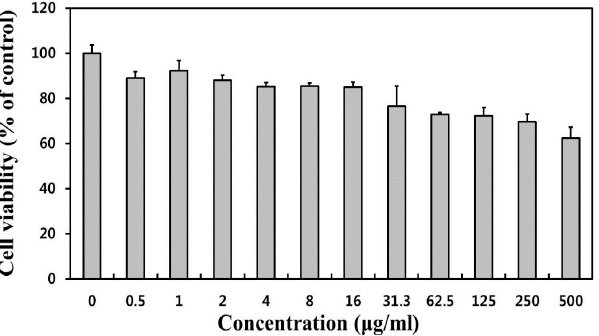
Figure 5. Cytotoxicity profiles of PEG–Ho 2 O 3 NPs in L-929 fibroblastic cells.